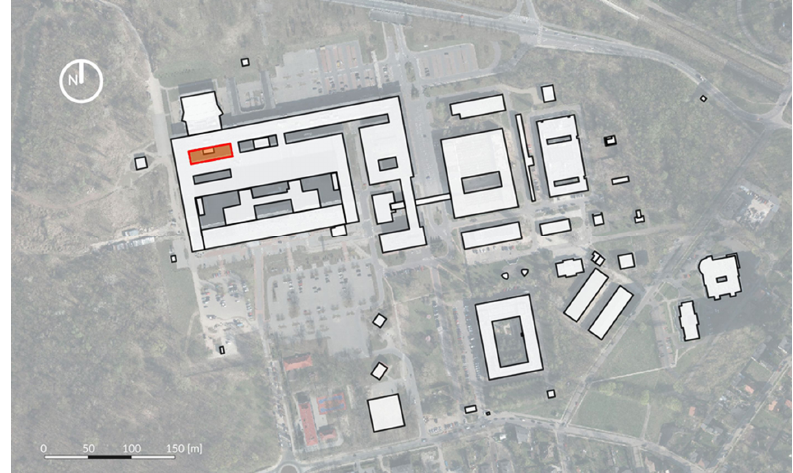
Figure 1. The clinical hospital of Medical University of Lodz: the atrium is placed in the northwestern part of the complex and marked in the picture with the red border. Figure by authors.